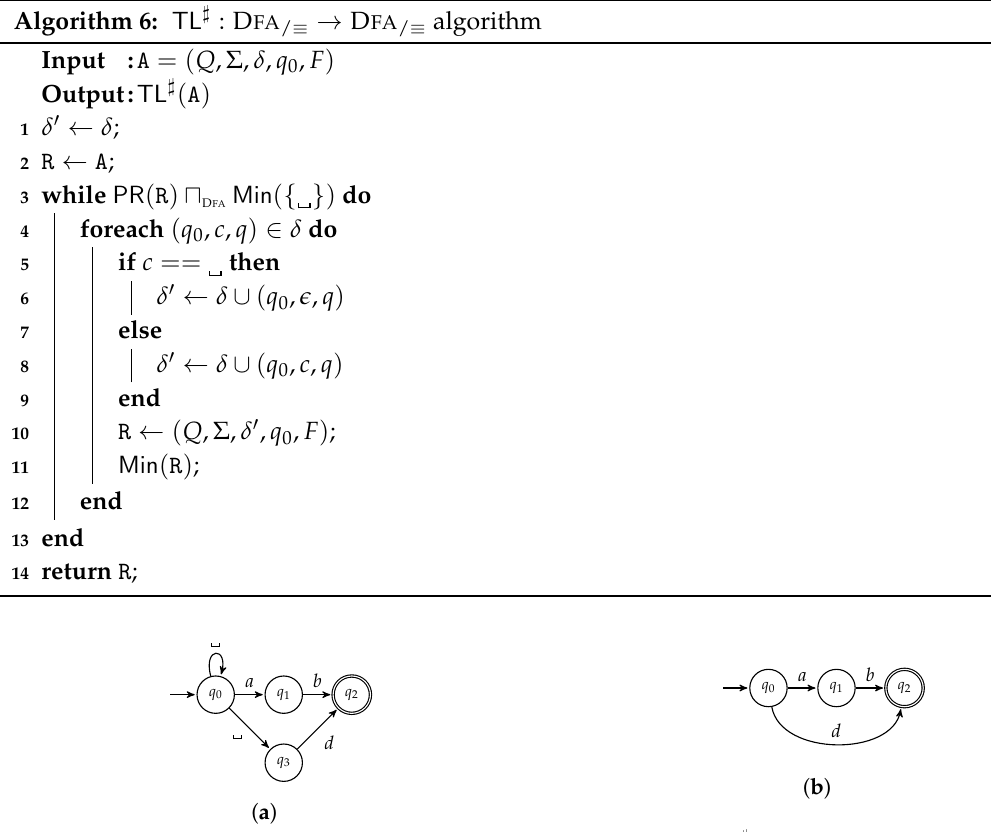
Figure 14. ( a ) A , L ( A ) = { ( ) ∗ ab , d } , ( b ) TL (cid:93) ( A )